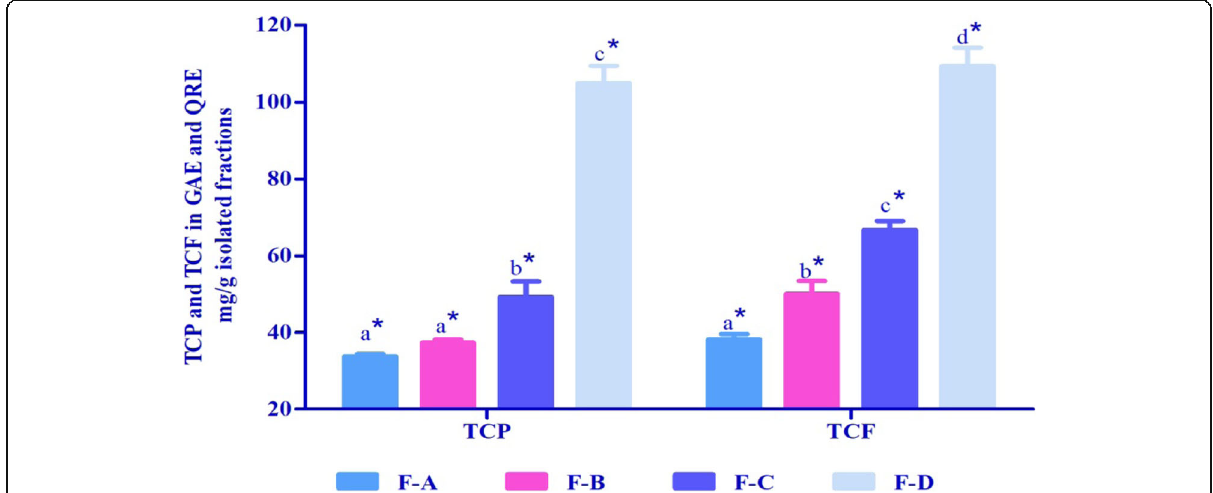
Fig. 1 TCP and TCF in the isolated pooled fractions of MeCV. Each vertical bar represents Mean ± SE for n = 3. The vertical bars having the same alphabet do not differ significantly, whereas the bars having the different alphabet differ significantly at P < 0.05(one-way ANOVA followed by Tukey ’ s post hoc test)